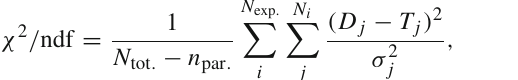
the pion and the kaon respectively. The reduced χ 2 for the fit is defined as,